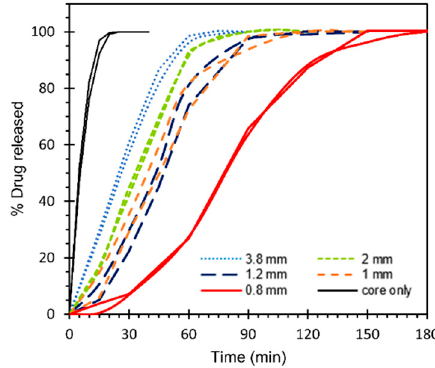
Figure 6. % Drug released vs. time for module variants with varying orifice size to determine the final orifice size for selection of MV3. The core only and MV1 with a 3.8 mm diameter exposed core face are presented as references. Data is presented as the minimum and maximum of n = 2 samples.